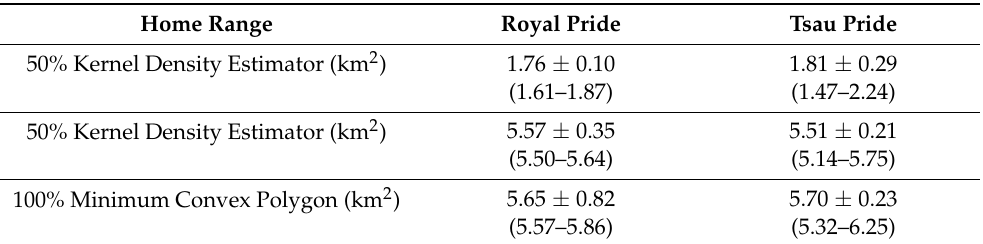
Table 6. Pride home range size of lions in the Tula Tsau Conservation Area, South Africa, between 2010 to 2011 (Royal Pride) and 2018 to 2020 (Tsau Pride) (adult males: n = 3; adult females: n = 3; subadult males: n = 4; subadult females: n = 2).